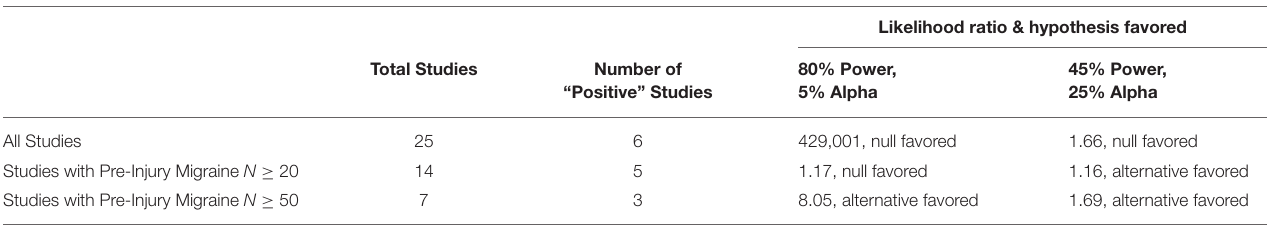
TABLE 4 | Likelihood ratio